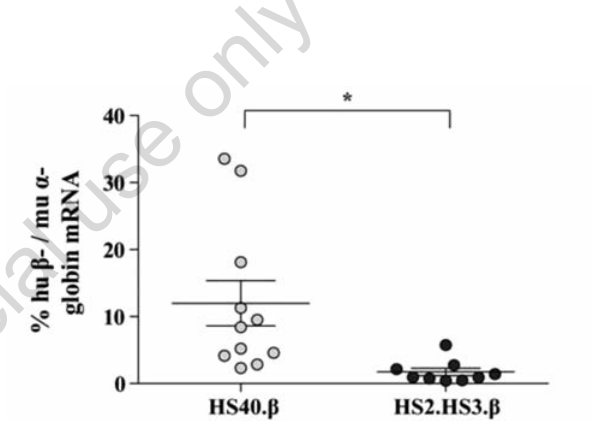
Figure 2. Foamy VirusVector performance in murine Lin- HSCs. Relative quantitation of human b -globin expression in individual mouse BFUe. Total mRNA levels were analyzed by Taqman real- time PCR for the expression of human b -globin and endogenous murine a -globin. The levels of human b -globin gene were calcu- lated as percentage of the endogenous mouse a -globin gene. Each symbol represents a single BFUe.